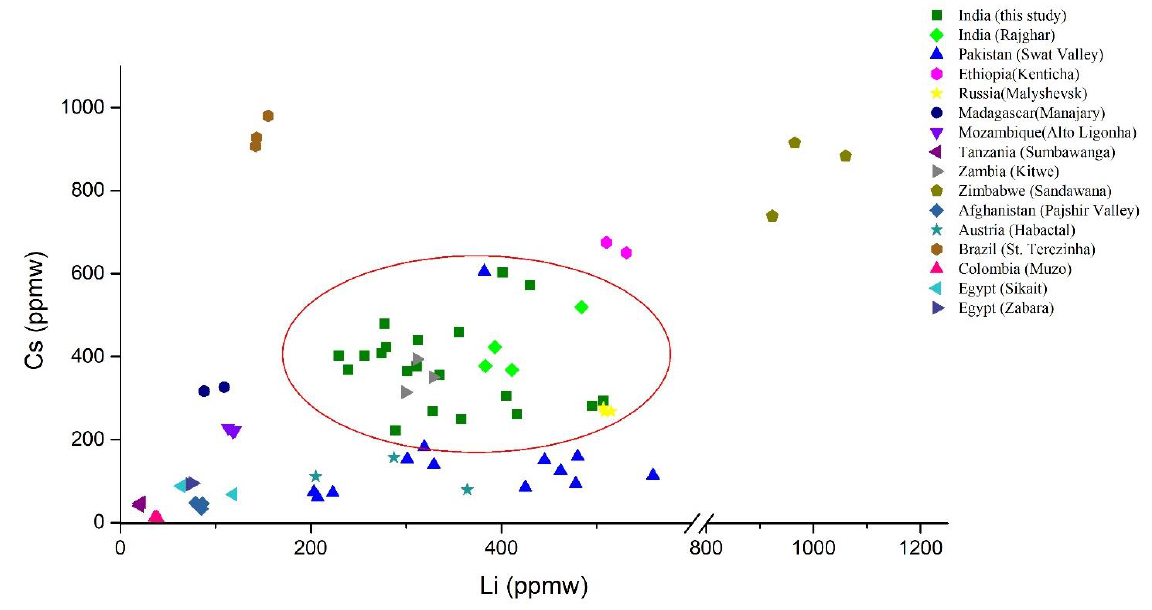
Figure 14. Plot of lithium (Li) versus cesium (Cs) concentrations from LA-ICP-MS analyses. Data are expressed in ppmw. Other sources are from [1,4,53,56].